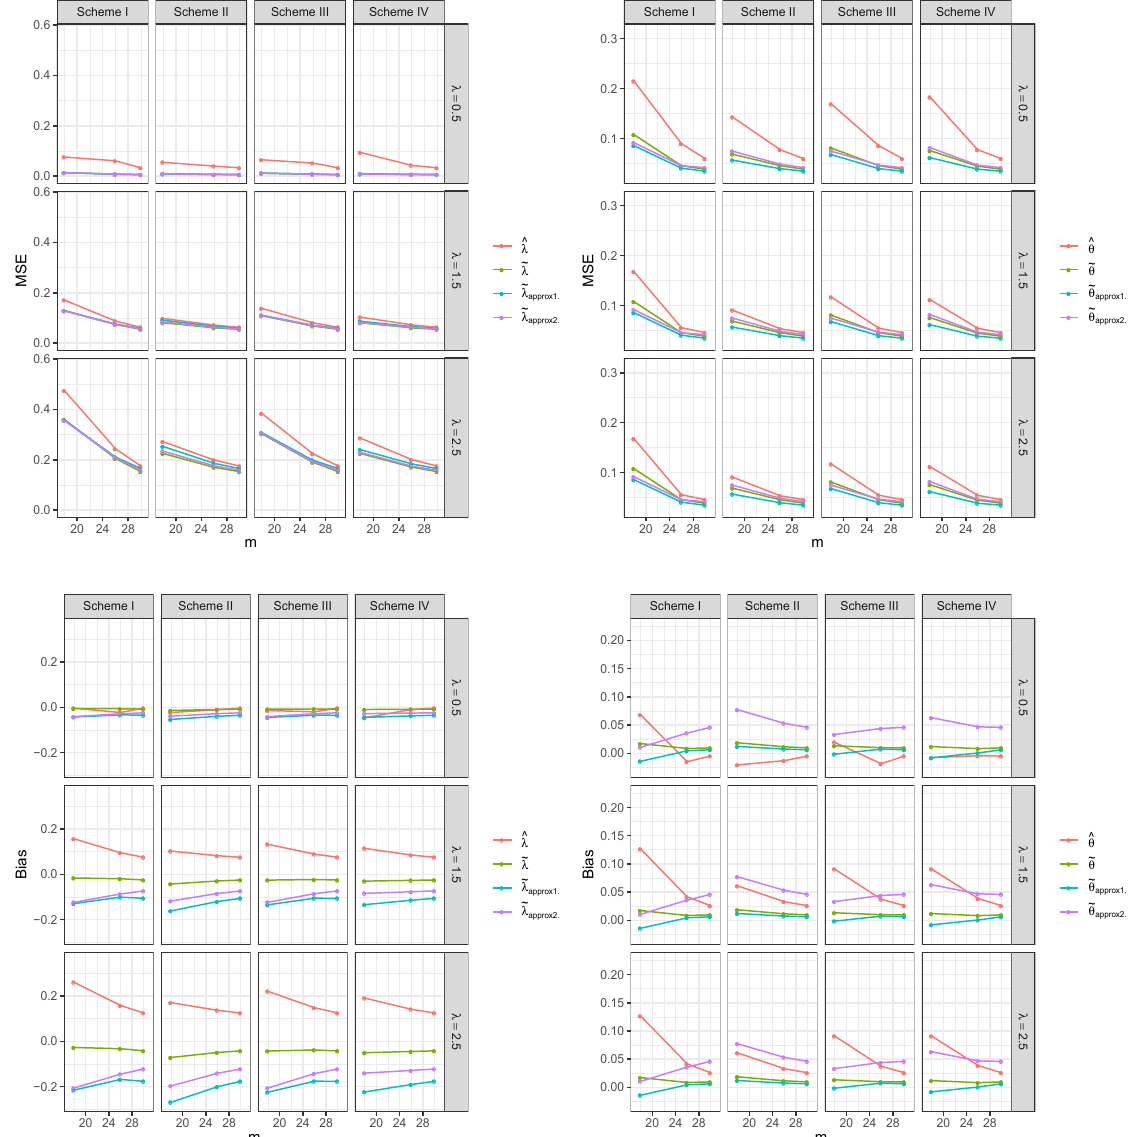
Figure 2. The MSEs and biases of the estimators for the sample size n =